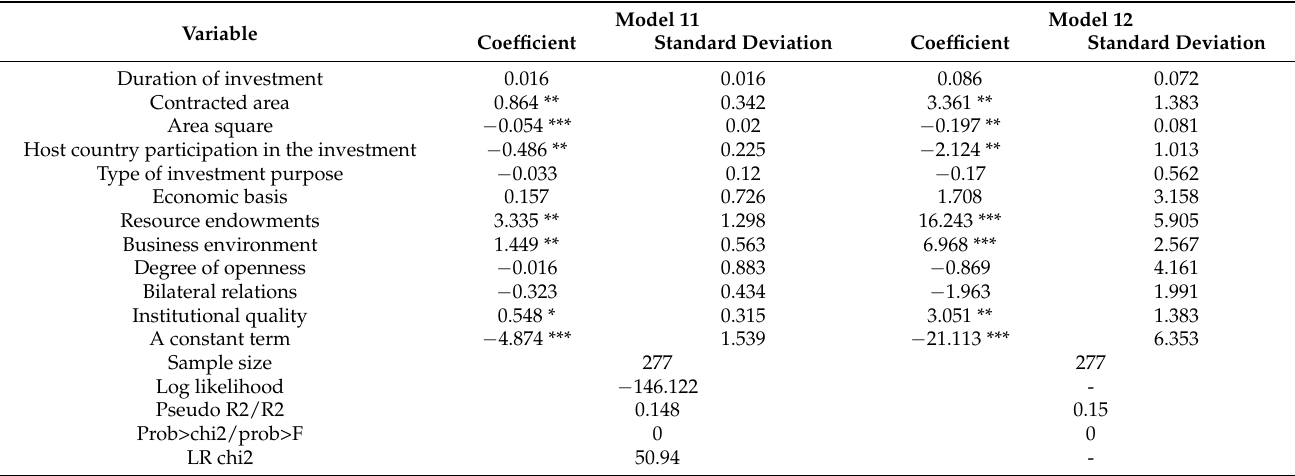
Table 8. Robustness test regression